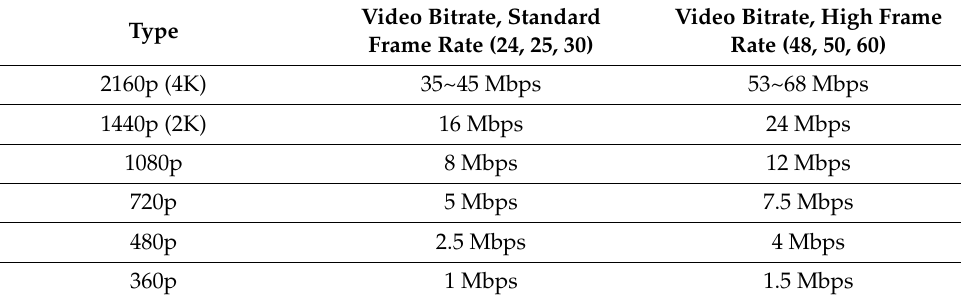
Table 1. Recommended video bitrates for video stream service